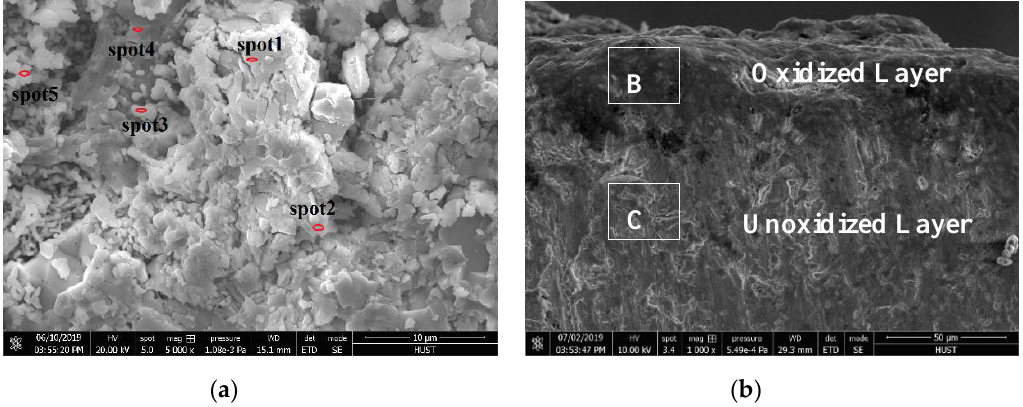
Figure 10. Surface and cross-section morphologies of the oxidized substrate at 1100°C for 110 h, ( a ) Surface morphology; ( b ) Cross-section morphology.